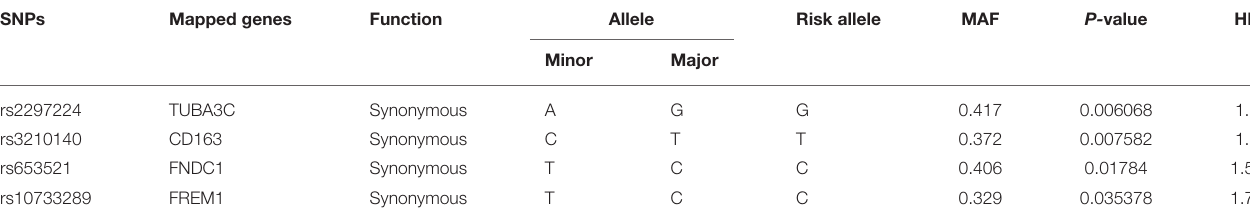
TABLE 3 | Statistically significant variants using Cox proportional hazard analysis in recessive